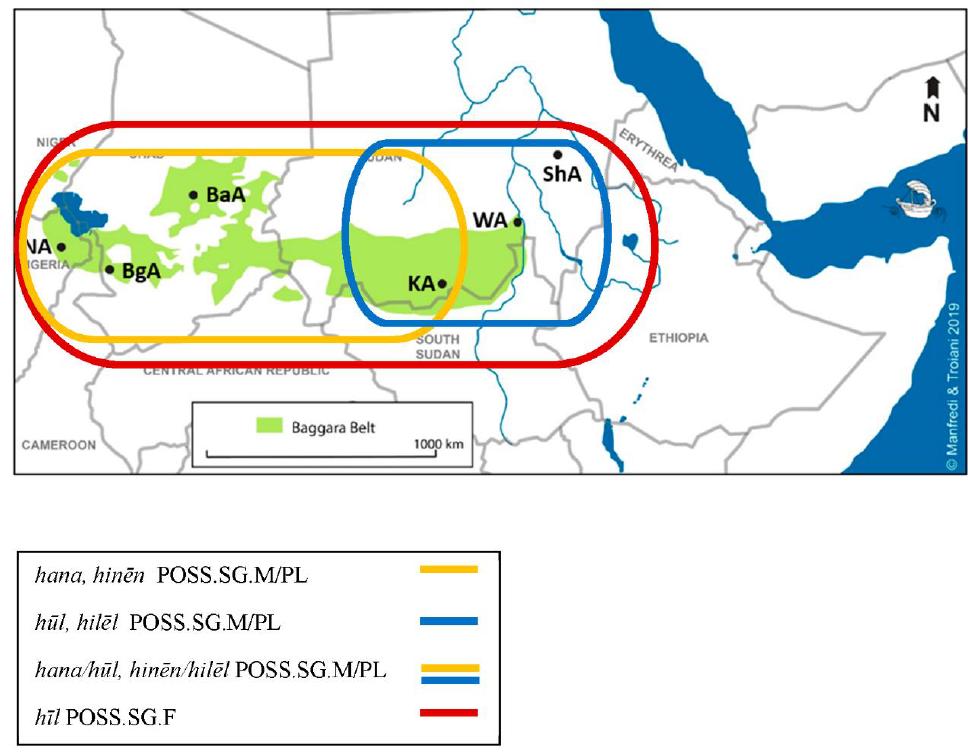
Figure 7. Possessive